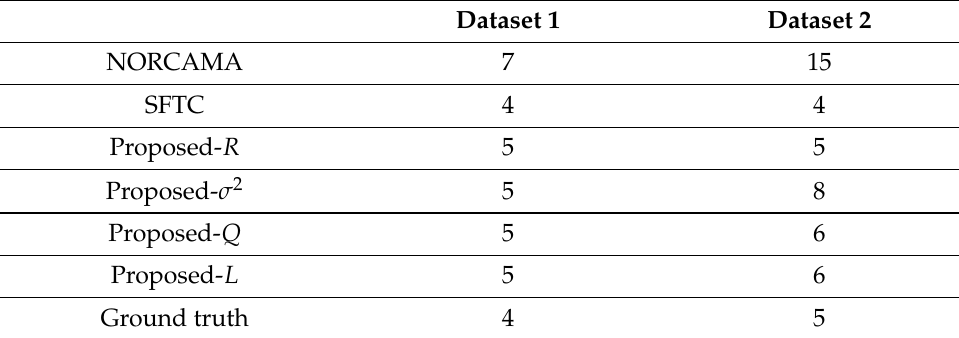
Table 3. The different values K generated by different